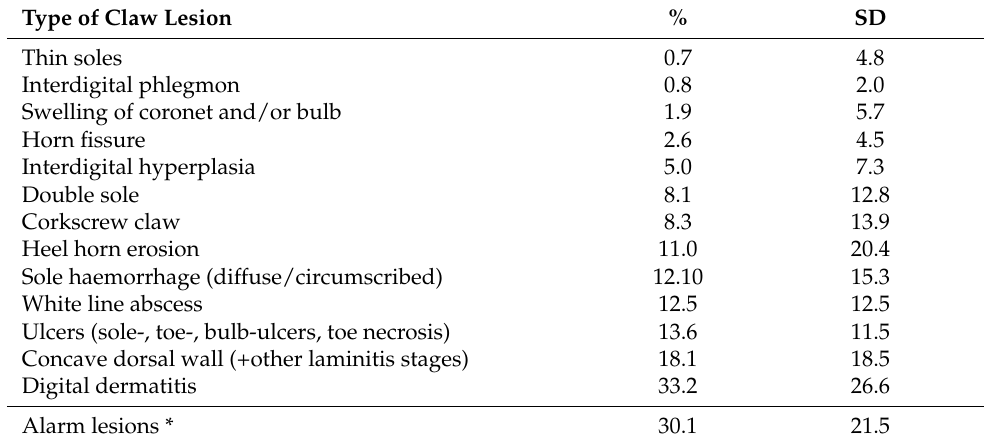
Table 2. Mean incidence risks of 13 claw lesions in cows from 512 dairy herds for